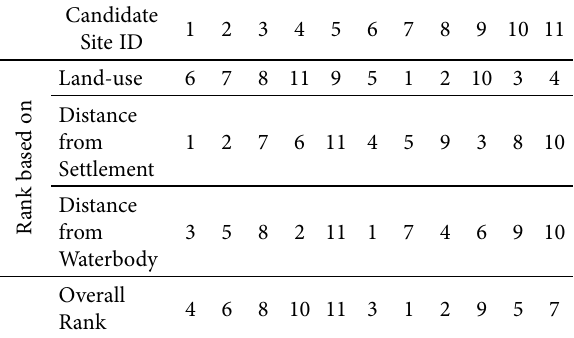
Table 4. Rank of Candidate